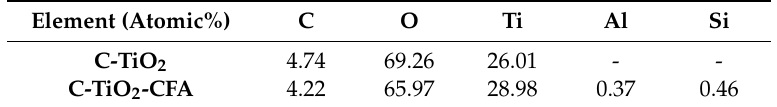
Table 1. Atomic weight percentages of the elements present in C-TiO 2 and C-TiO 2